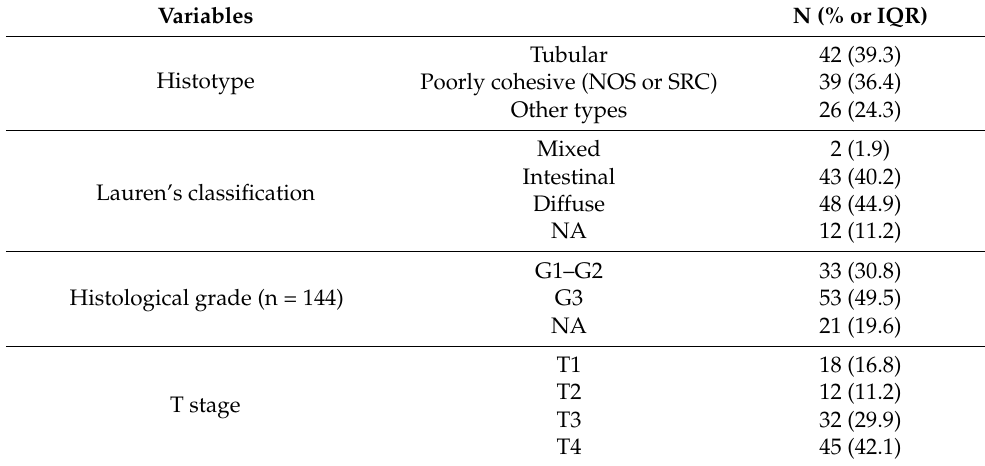
Table 2. Histopathological